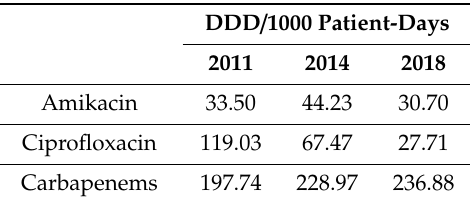
Table 4. Consumption of selected antibiotics in intensive care units (ICUs) in the years